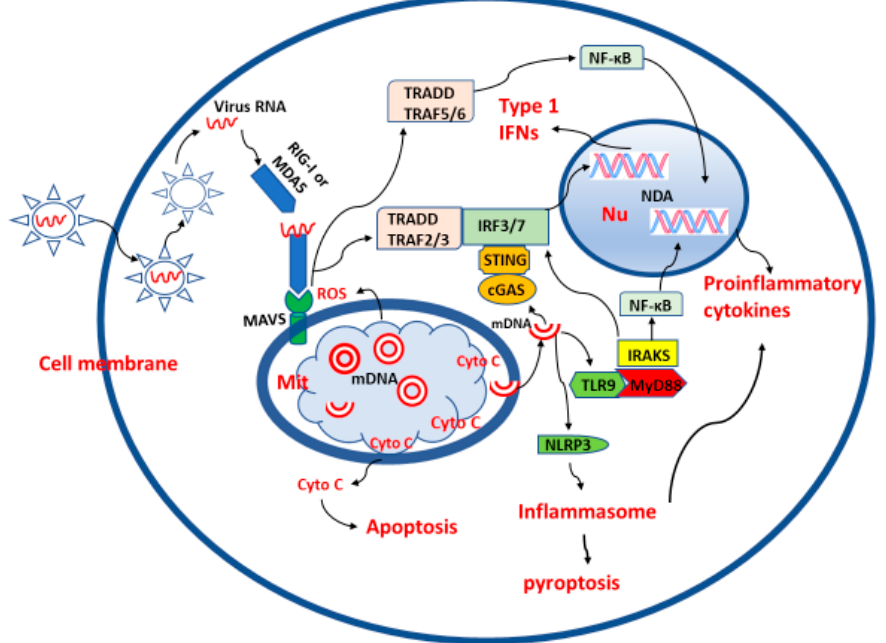
Figure 1. The roles of mitochondria in virus infection. For avoiding unnecessary complexity, the processes of virus uptake, passage through membranous compartments, release and disassembly of nucleocapsid, the respective representation has been strongly simplified. MIT: mitochondria, Nu: nucleus, red cycles: mitochondrial circular double strand DNA (mDNA), semi red cycles: broken mitochondrial double strand DNA, Double helix: nuclei DNA, Cyto C: cytochrome C, red wave lines: single strand viral RNA, the arrows indicate the directions of the links.